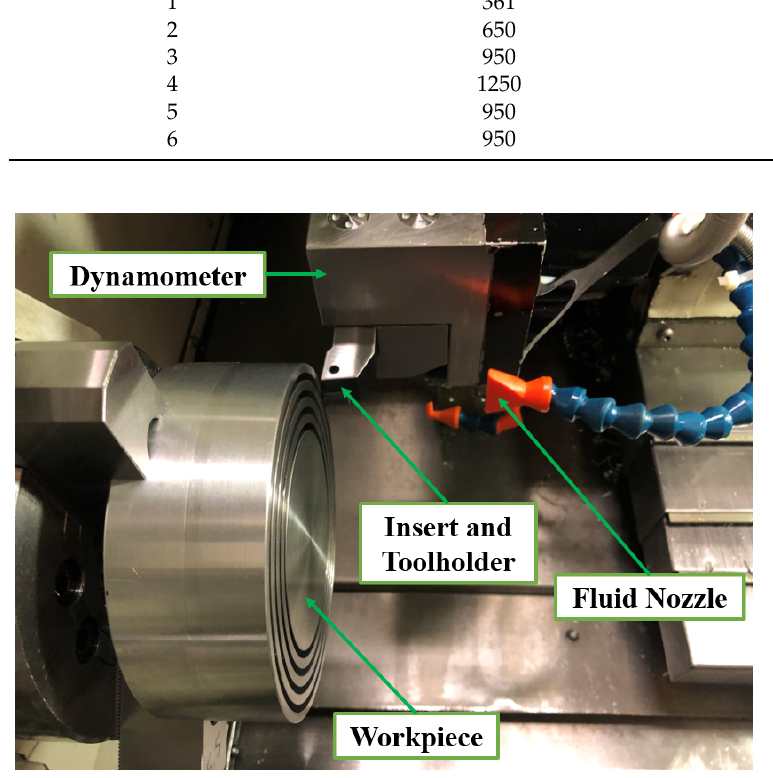
Figure 1. The experimental set-up of orthogonal machining.